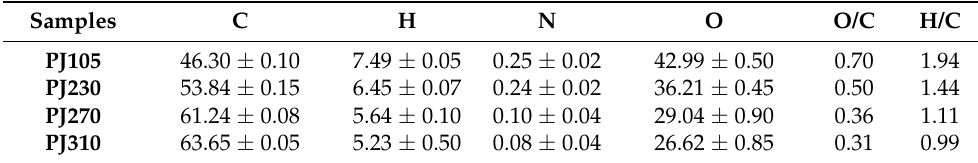
Table 2. Ultimate analyses of P. juliflora samples.